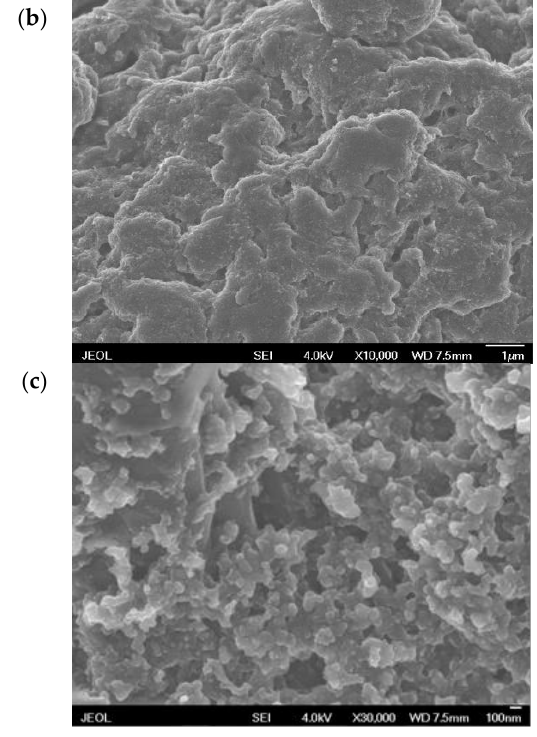
Figure 5. SEM images of ( a ) SPE, ( b ) ILSPE and ( c ) Fe 3 O 4 /ILSPE.